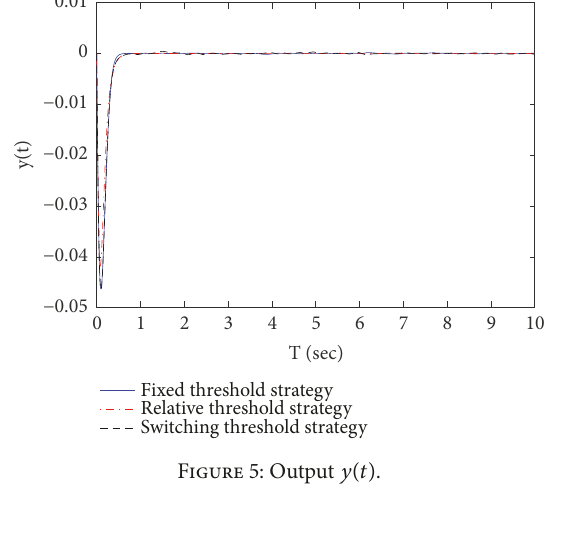
Figure 5: Output 𝑦(𝑡) .